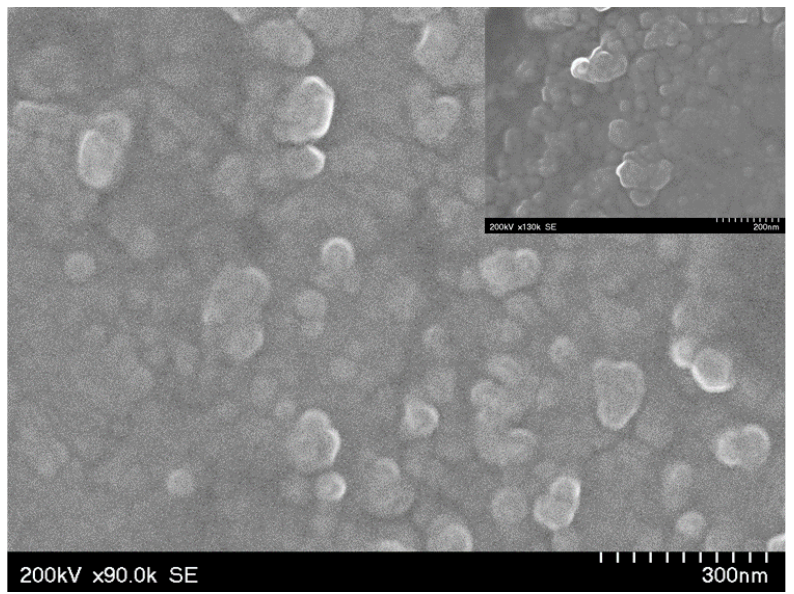
Figure 3. Scanning TEM image (SE mode) of nicotine−stearic acid conjugate-loaded SLNs. A slightly higher resolution image is provided in the inset.